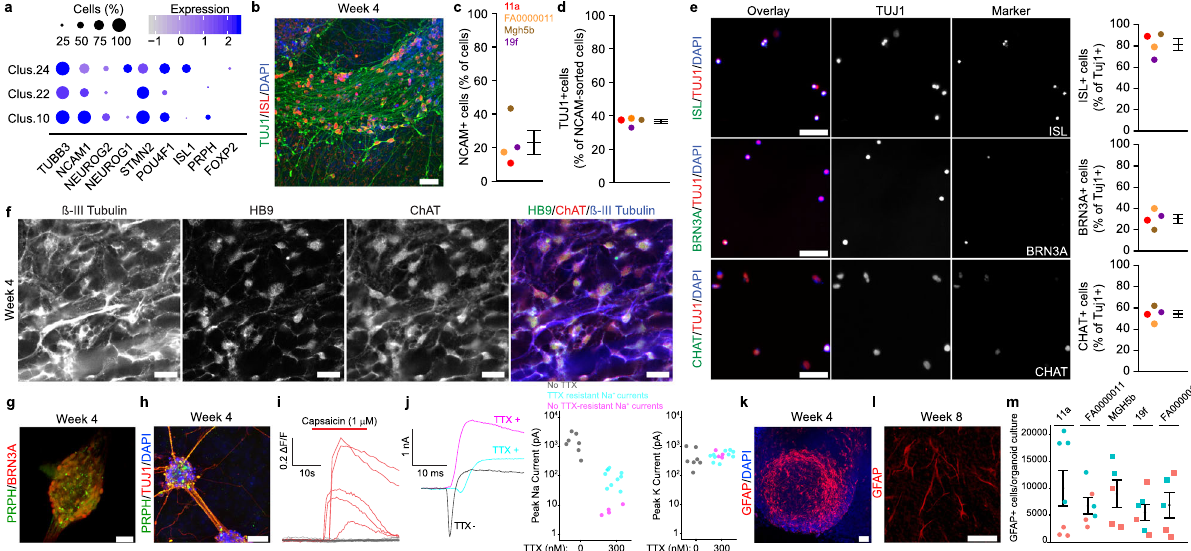
Fig. 3 Sensorimotor organoid cultures generate cells of an ectodermal lineage, including sensory and motor neurons and astrocytes. a Dot plot of gene expression within neuronal clusters from single-cell RNA-seq data. Color intensity indicates expression level; dot size indicates the proportion of cells expressing each gene. b ISL + /TUJ1 + neurons in 4-week-old organoid cultures. c NCAM + cells after FACS. d TUJ1 + NCAM + FACS puri fi ed cells (from ( c )). e Staining (left) and quanti fi cation (right) of neuronal subtypes after FACS by expression of ISL (top), BRN3A (middle), and CHAT (bottom). For ( c ) – ( e ), one independent biological differentiation for each of control lines: 11a (red), FA0000011 (orange); and ALS lines: MGH5b (brown), and 19f (purple) at 4 weeks. f HB9, ChAT, and β -III tubulin labeling of motor neurons in 4-week-old cultures (three independent biological differentiation replicates of FA0000011). g BRN3A and PRPH staining of ganglia in 4-week-old cultures. h Ganglia connected by PRPH + /TUJ1 + axonal processes. i Sample calcium imaging traces of individual cells in ganglia-containing fi elds with (red) and without (gray) response to capsaicin at 6 – 7 weeks. Capsaicin sensitivity was con fi rmed in three independent biological differentiation replicates of two lines (11a, MGH5b). j Example whole-cell patch-clamp current traces recorded in the absence (gray) or presence of 300 nM TTX (cyan, cell without TTX-resistant sodium currents; magenta, the cell with TTX-resistant sodium currents). Quanti fi cation of peak sodium (middle) and potassium (right) current amplitudes in the absence (gray) or presence of TTX (cyan, cell without TTX- resistant currents; magenta, a cell with TTX-resistant currents). Recordings from four independent biological differentiation replicate of FA0000011 (sodium currents: n = 4 cells without TTX resistant currents, and n = 10 cells with TTX resistant currents, Mann – Whitney, U = 0; P = 0.002; potassium currents: n = 4 cells without TTX resistant currents, and n = 10 cells with TTX resistant currents, U = 19; P = 0.945). k GFAP + astrocytes in 4-week-old cultures. l Astrocyte morphology at 8 weeks. m GFAP + cells in 6-week-old cultures. ( n = 5 – 7 cultures from two independent biological differentiation replicates for each of fi ve indicated lines; Kruskal – Wallis, P = 0.388). Scale bars 25 ( f ), ( g ), 50 ( e ), ( k ), ( l ), and 100 ( b ), ( h ) µ m. Bars indicate mean and